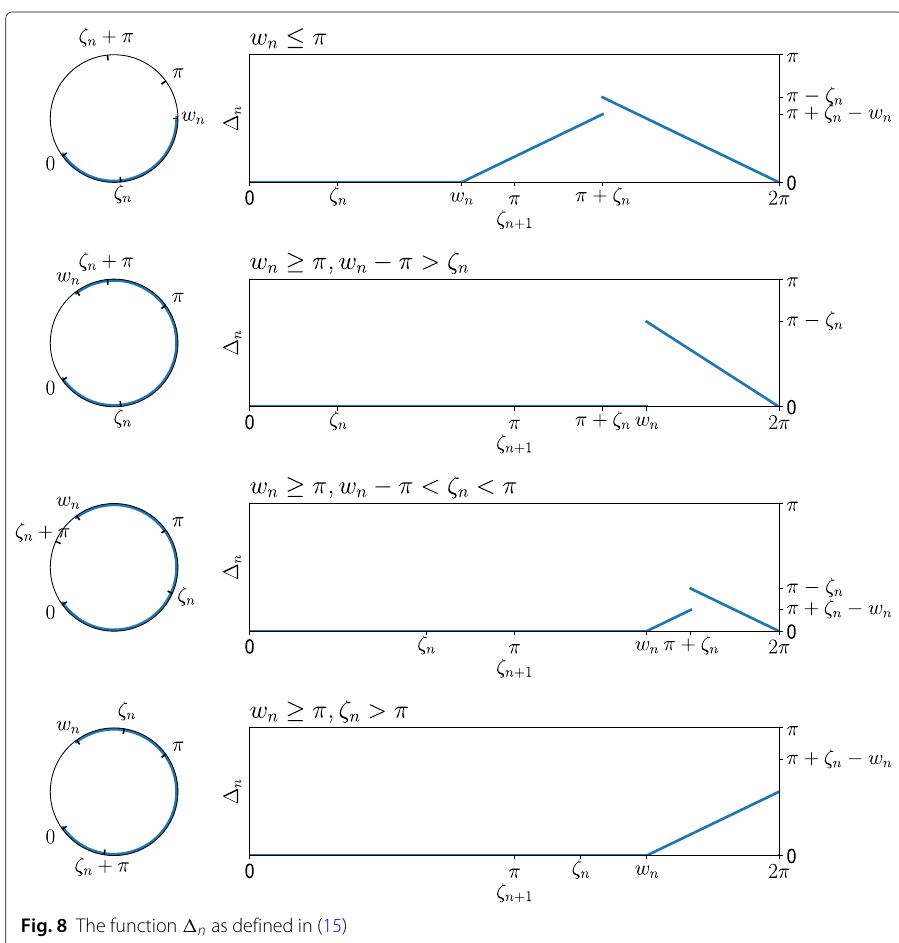
Fig. 8 The function (cid:2) n as defined in (15)